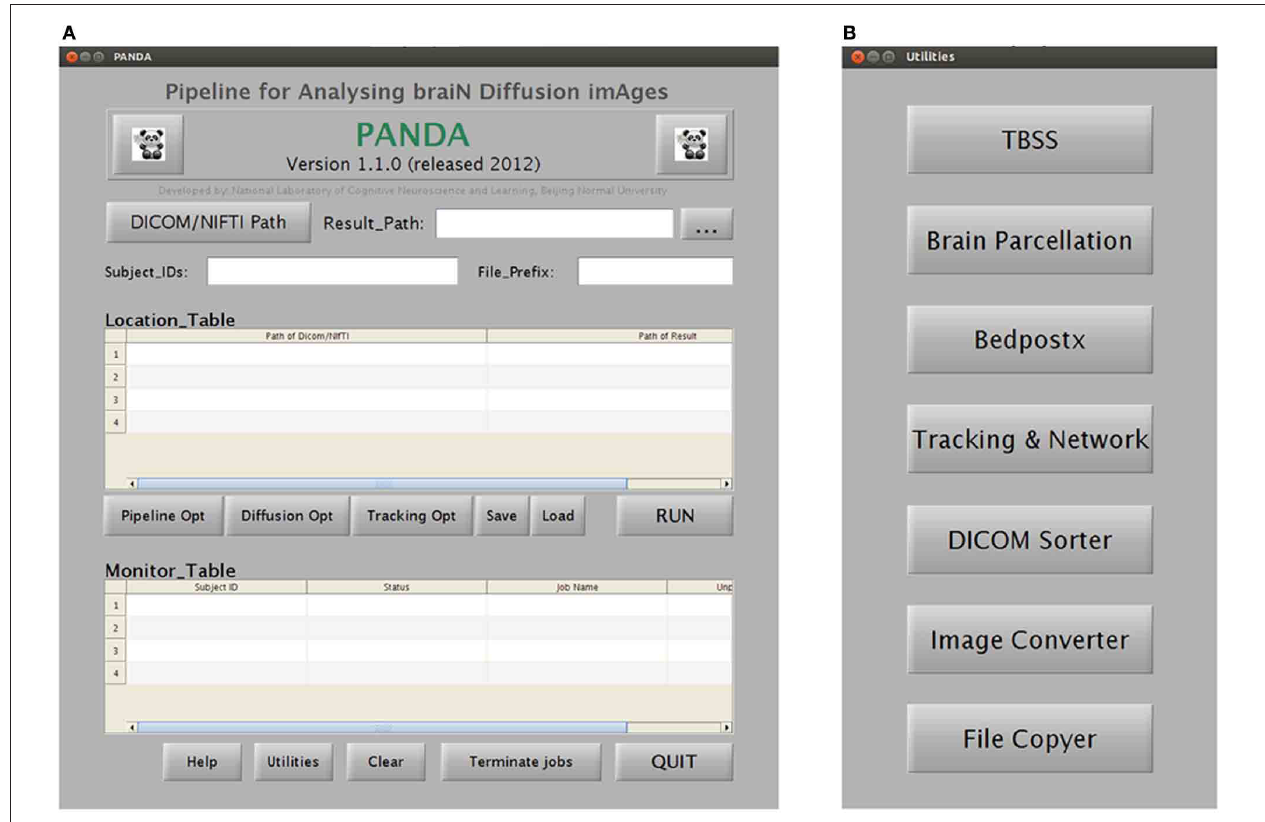
FIGURE 4 | A snapshot of the GUIs of PANDA. (A) The main GUI for loading dataset and monitoring job status. (B) The GUI for initiating separate